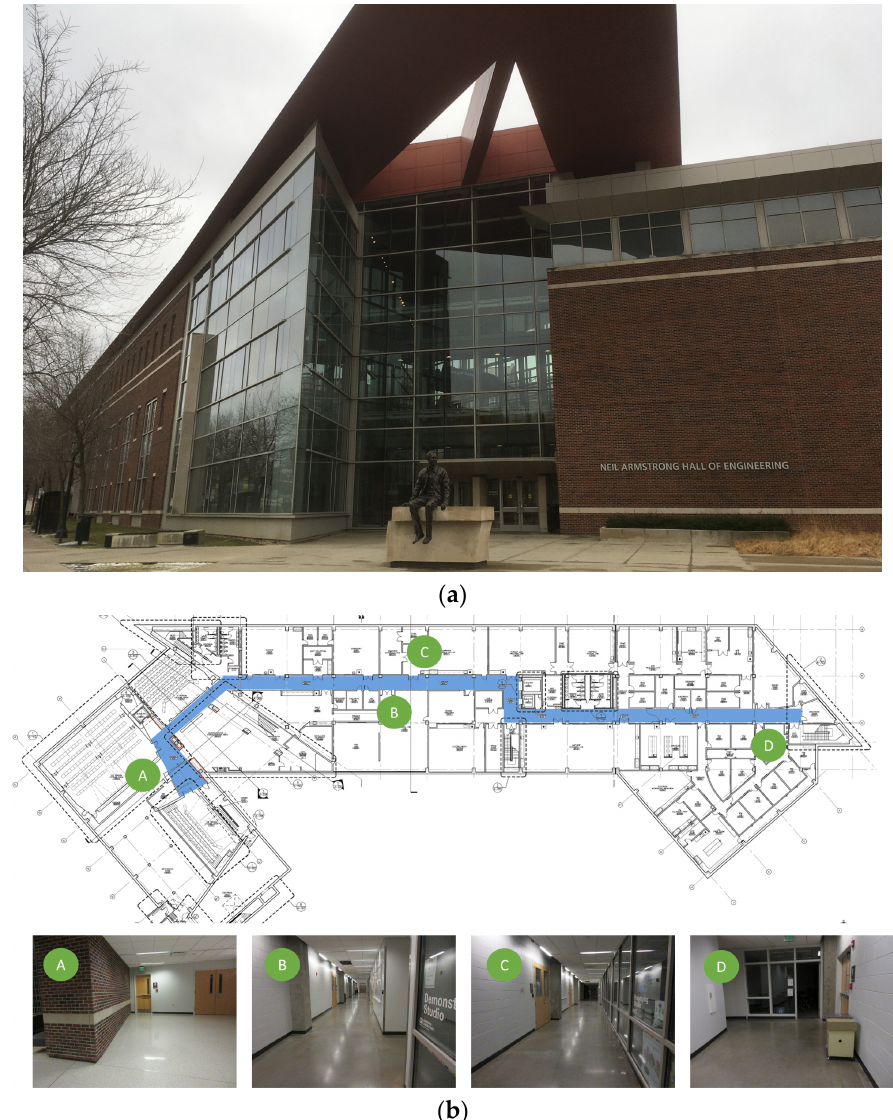
Figure 4. Experimental test site (Armstrong Hall at Purdue University, United States): ( a ) building overview and ( b ) basement floor plan: InspImgs and PathImgs are collected along the corridor highlighted as solid blue. Sample images corresponding to key spots in the corridor are